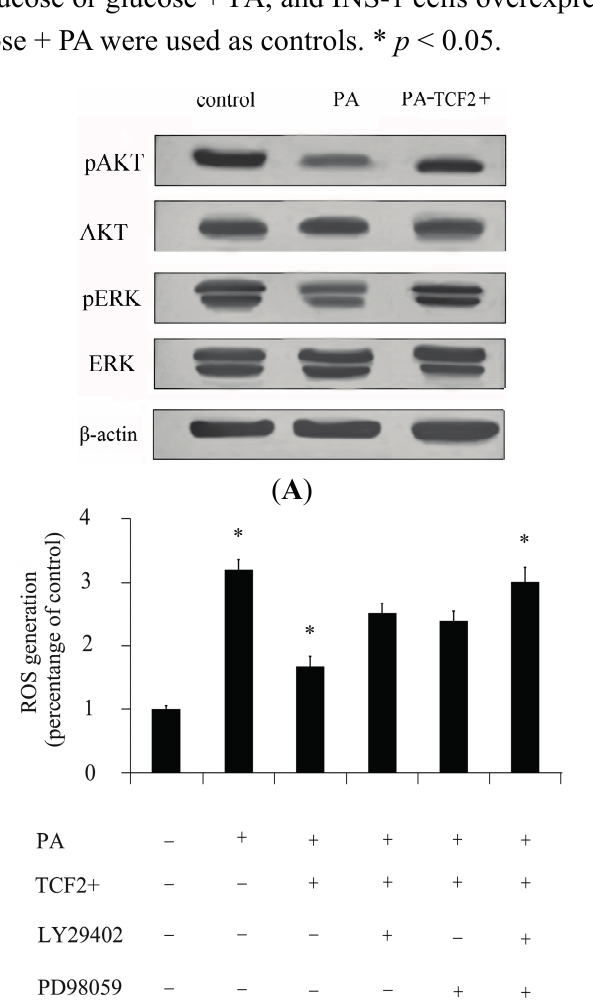
Figure 3. TCF2 activates PI3K/AKT and MAPK/ERK signaling pathways to inhibit